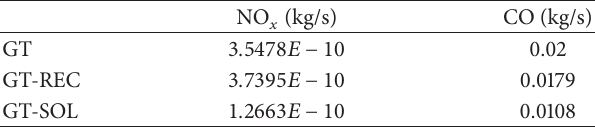
Table 3: NO 𝑥 and CO